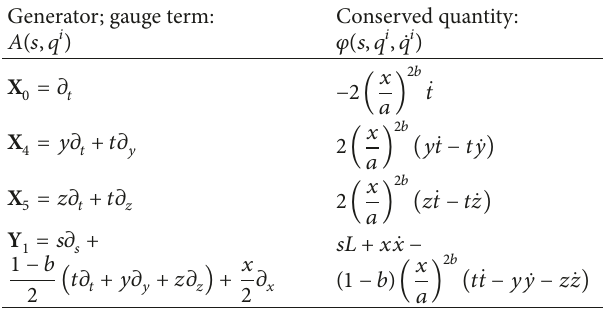
Table 26: Conserved quantities corresponding to each Noether symmetry.